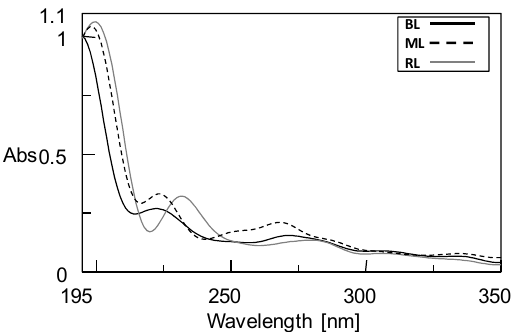
Figure 5. UV spectra of extracted material.